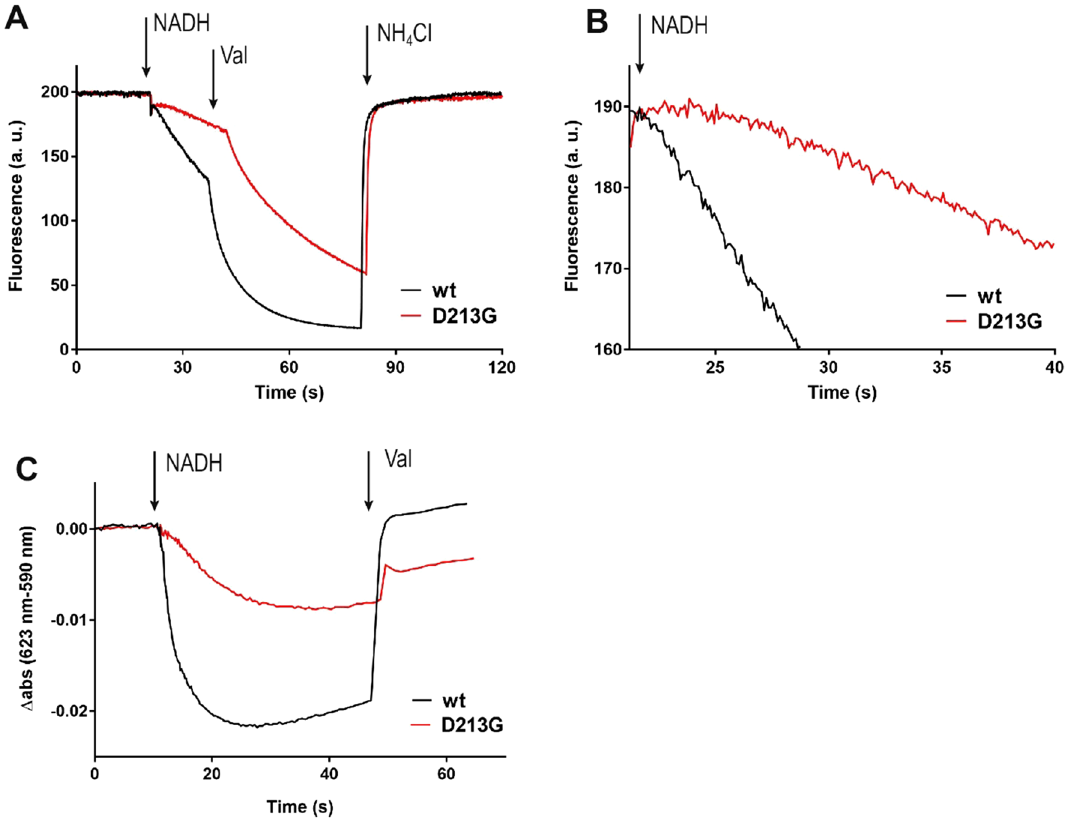
Figure 6. Generation of a pmf by E. coli complex I (black) and the D213G H variant (red) reconstituted into liposomes. ( A ) Generation of a ΔpH measured as quench of the ACMA fluorescence. The reaction was started by addition of 130 µM NADH. Addition of valinomycin dissipates the Δψ and accelerates NADH turnover